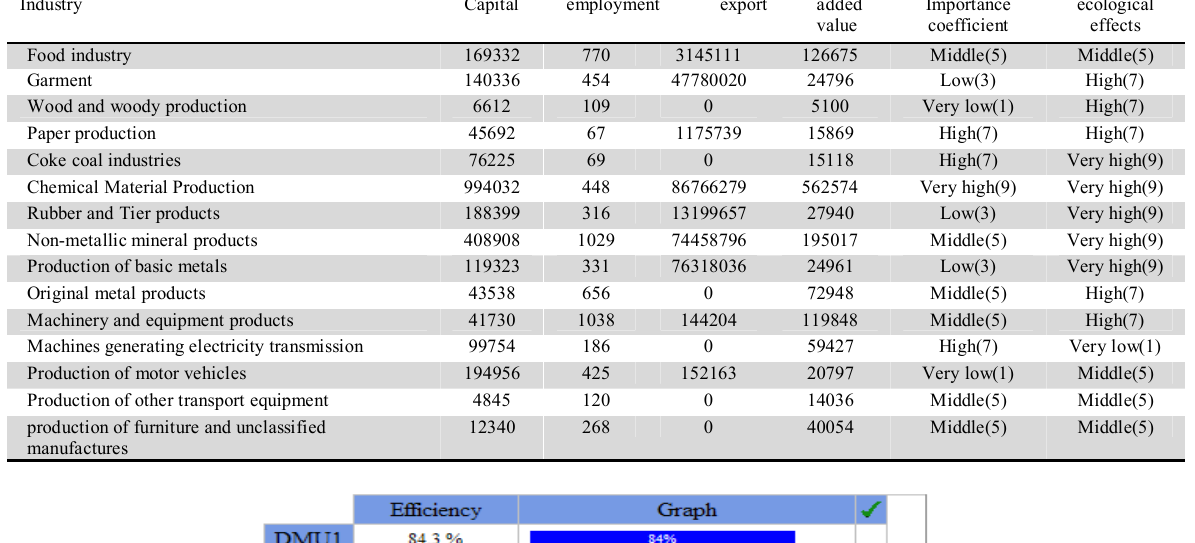
export employment Capital Industry